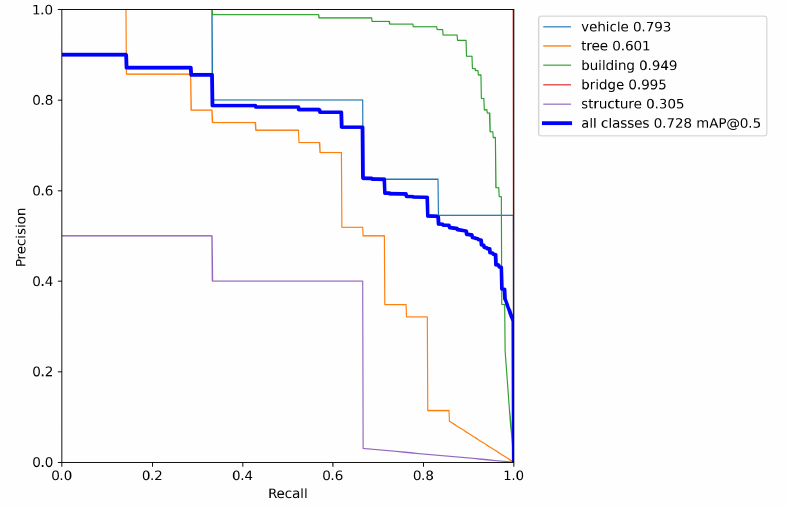
Figure 8. The result of using the YOLOv5s model. The YOLOv5 model performs well. Bridges and buildings, in particular, are massive structures that require tremendous precision even when